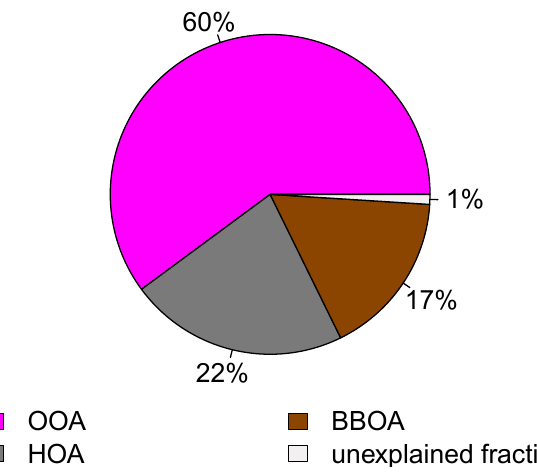
Fig. 9. Contributions of identified factors with AMS-PMF to mass concentration of organic compounds measured with the AMS (from 1 till 18 December